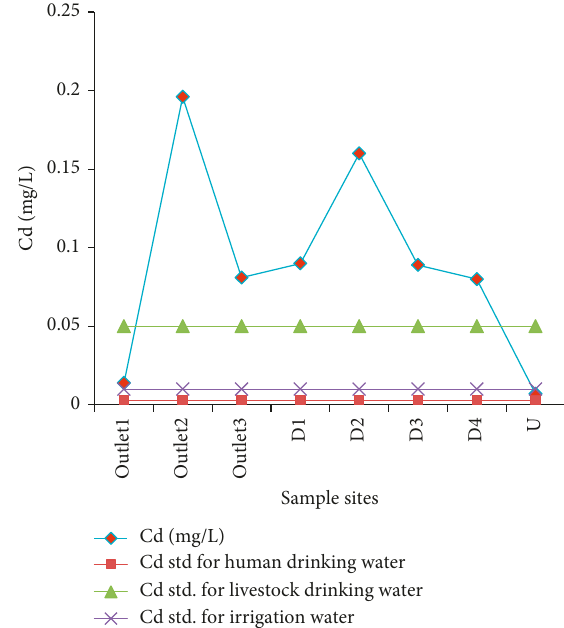
Figure 14: Comparison of the cadmium concentration in waste- water discharged from the Zenzelma campus and the recom- mended limits of